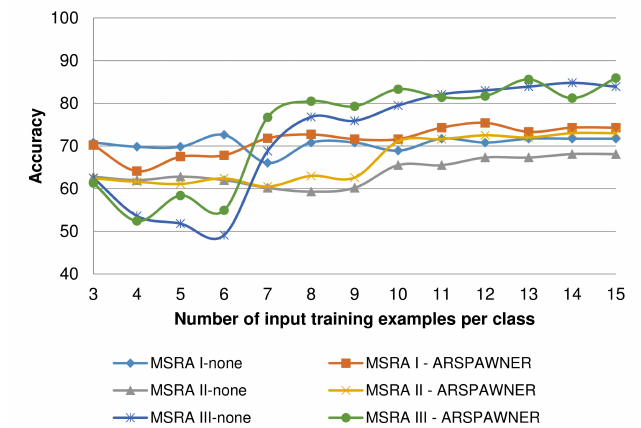
Figure 9. Average accuracy of the nearest neighbor classifier with the DTW distance based on a small number of augmented training examples per